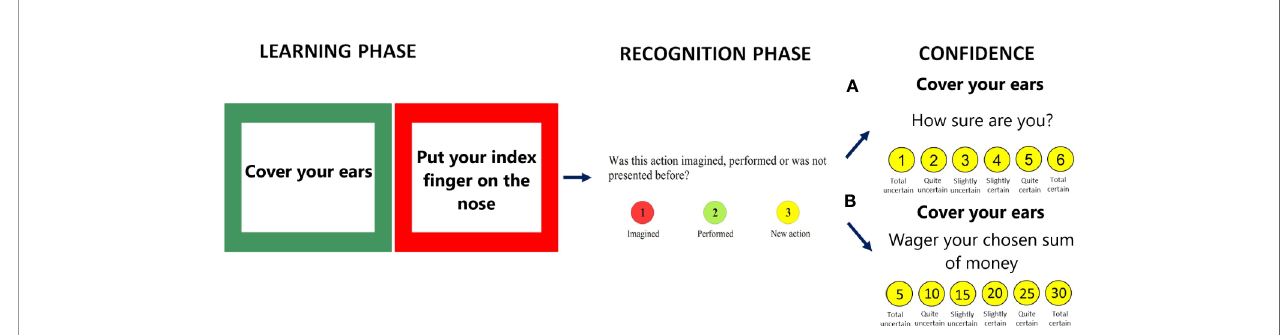
FIGURE 1 | The action memory task with con fi dence assessment: Demographic characteristics of the group of patients with schizophrenia and healthy control (A) CR scale or (B) PDW